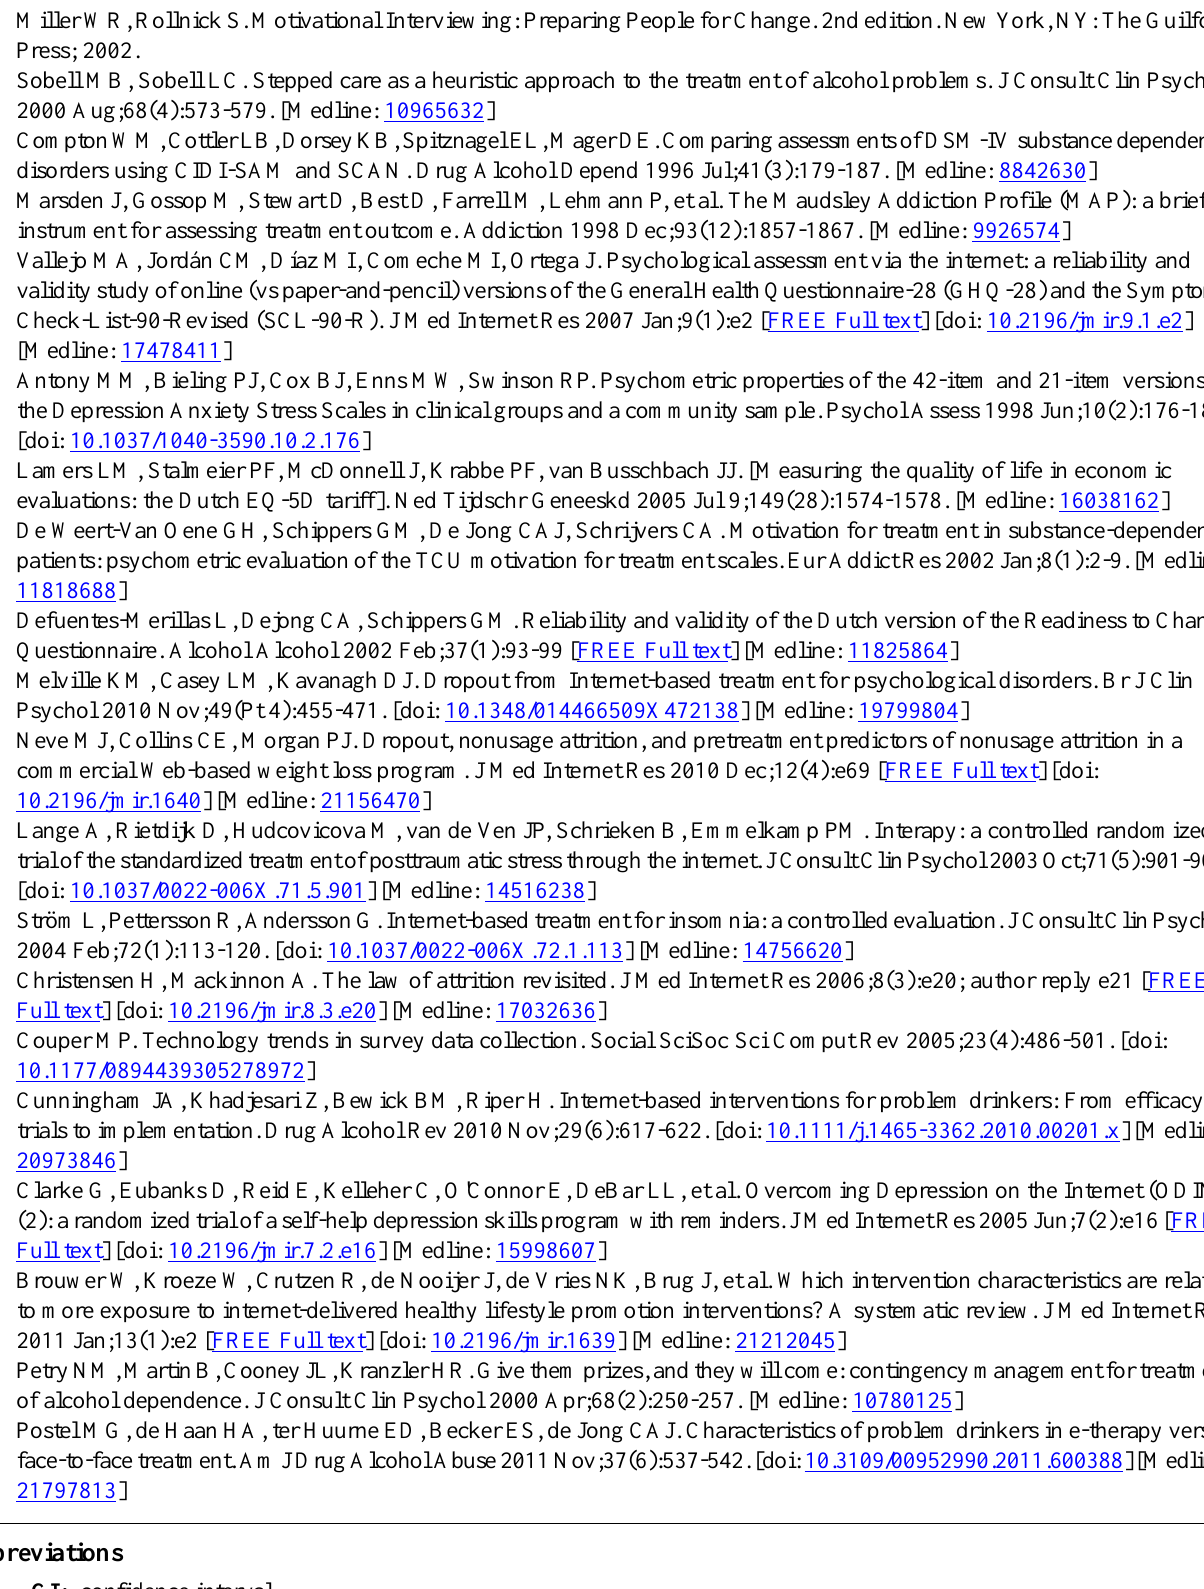
Abbreviations CI: confidence interval DASS-21: Depression Anxiety Stress Scale GHQ-28: 28-item General Health Questionnaire MAP-HSS: Maudsley Addiction Profile-Health Symptom Scale MfT: TCU Motivation for Treatment